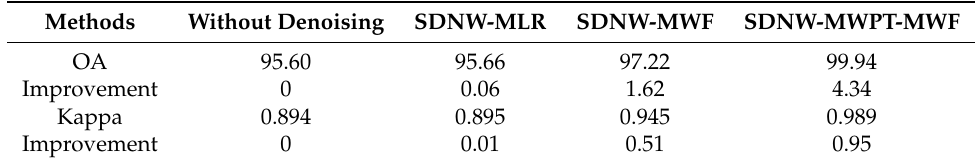
Table 5. OA (%) and Kappa of the classification of the denoised HYDICE HSI, SNR INPUT = 30 dB.